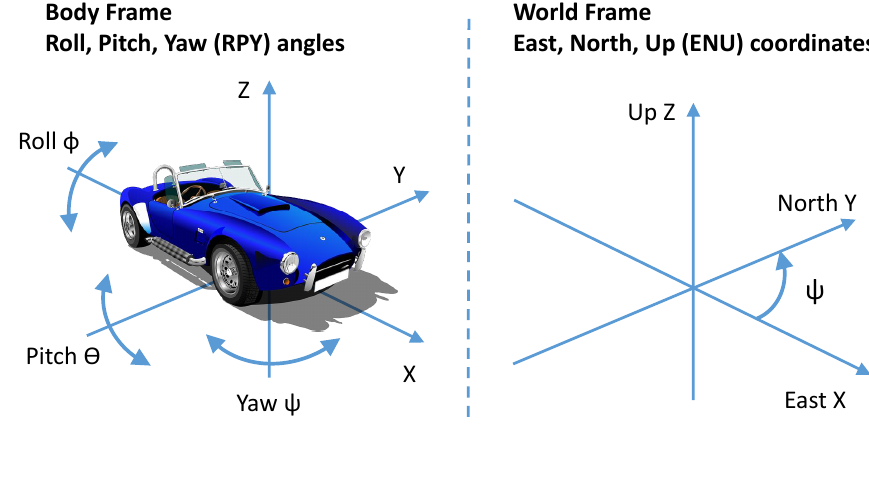
Figure 2. Reference